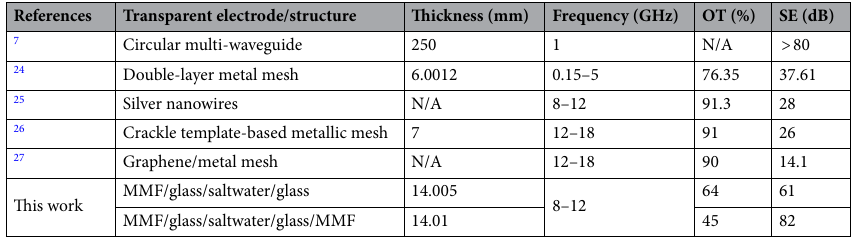
Table 2. Comparison of the proposed structures with other